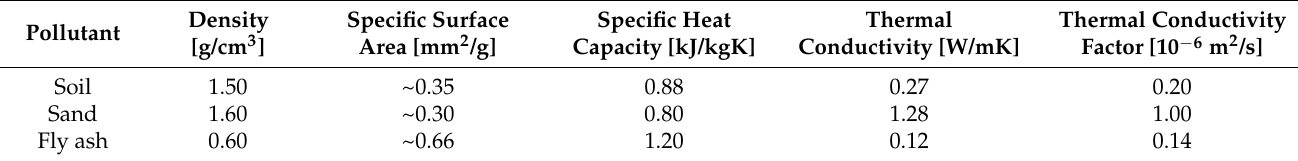
Table 3. Physical properties of dust.